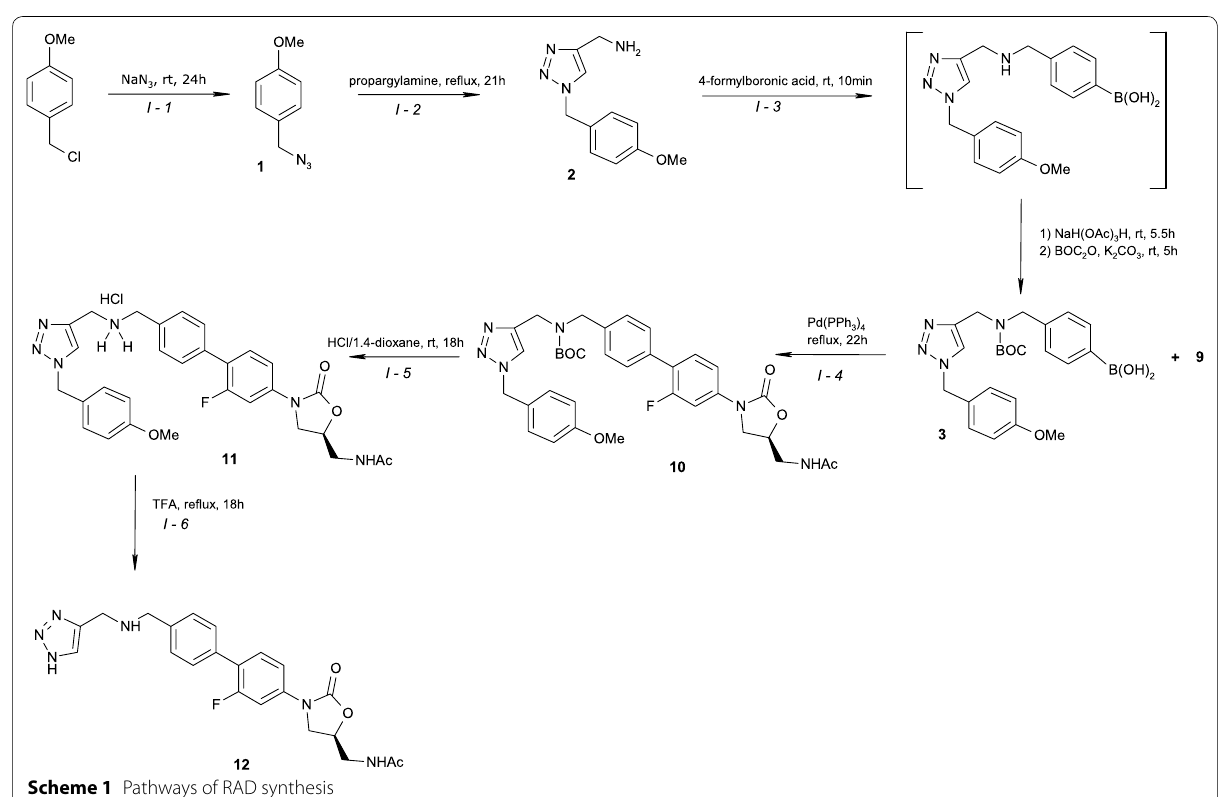
Scheme 1 Pathways of RAD